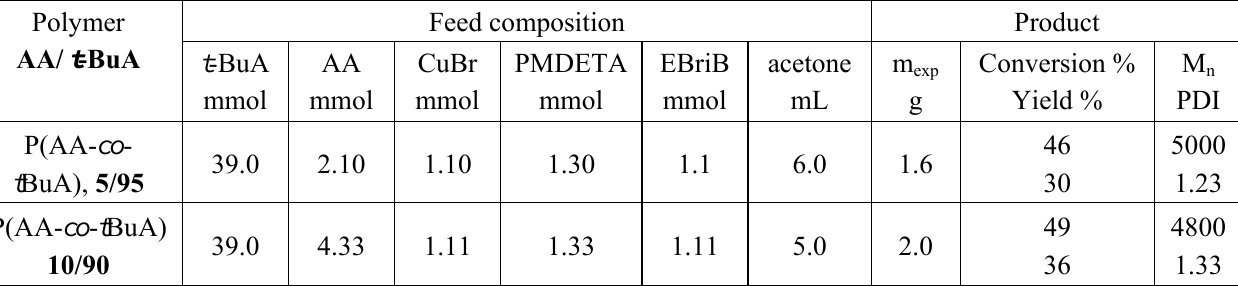
Table 2. Copolymerization of tert .butylacrylate ( t .BuA) and allyl acrylate (AA): feed composition and product